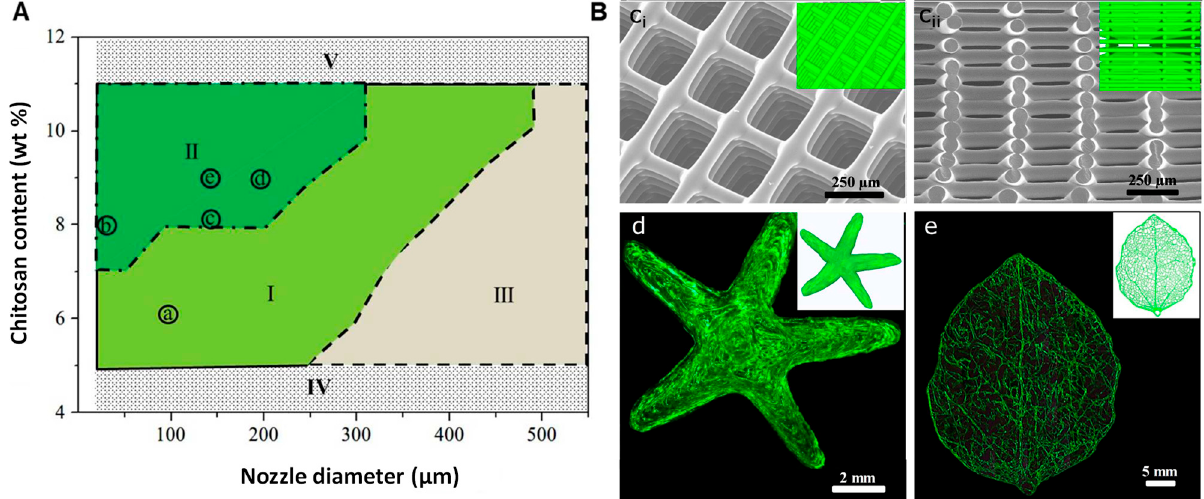
Figure 9. ( A ) Process map illustrating the ranges of chitosan contents and nozzle diameters compatible for the fabrication of various types of microstructures I, zone for 1D filament; II, zone for 2D filament array or 3D structure; III, zone where chitosan solutions lose shape fidelity; IV, zone where chitosan solutions are too diluted for the process; V; zone where the chitosan solutions are too viscous to be printed. The letters c–e represent the fabrication parameters of different structures shown on the right. ( B ): c i and c ii SEM top and side views of a 3D chitosan scaffold with square pore size; d and e, fluorescent microscopy images of a 3D printed starfish and a 3D printed leaf; respectively. Inset images show the corresponding CAD models. Adapted with permission from [124]. Copyright (2018) American Chemical Society.